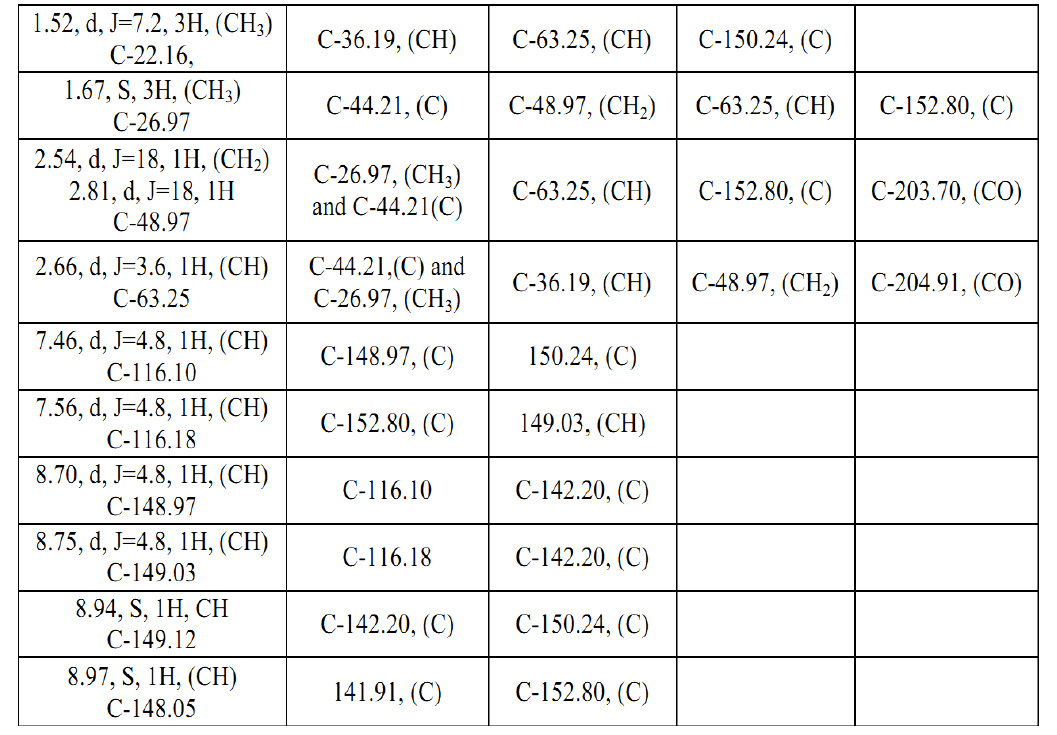
Table 2. Interpretation of the HMBC spectrum for compound 1 , (δ in ppm, J in